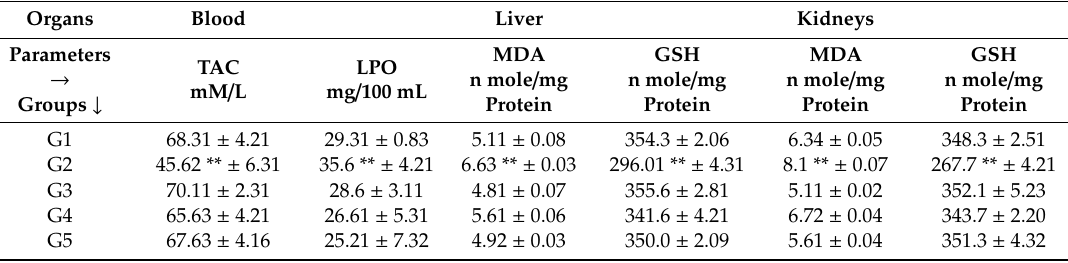
Organs Blood Liver